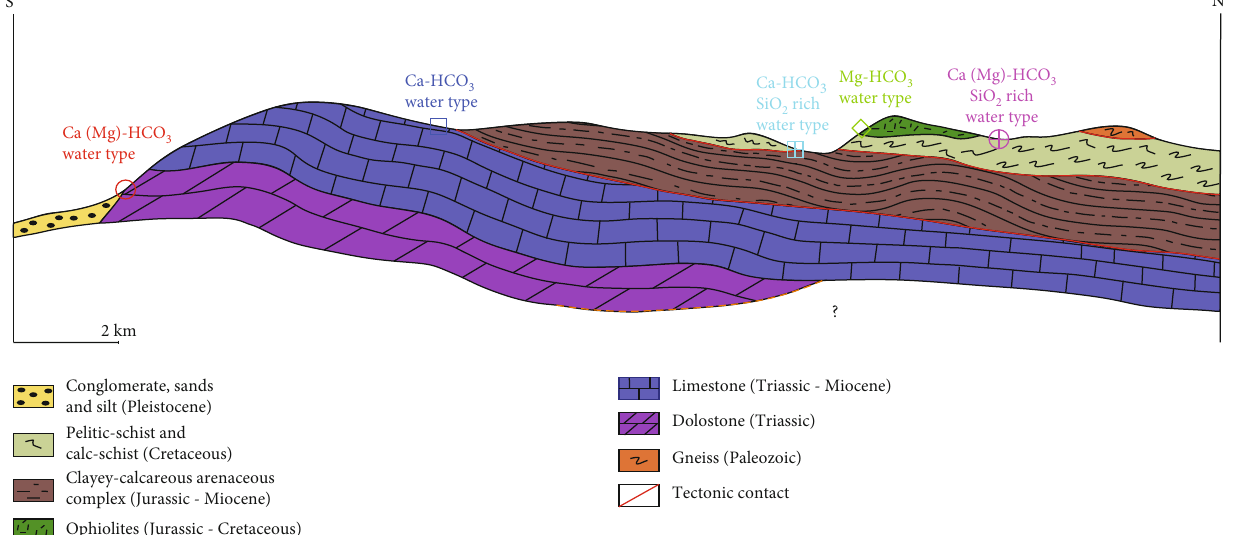
Figure 9: Schematic geological section (the trace is reported in Figure 1) representing the main units cropping out in the study area and the typical emergency area for each chemical